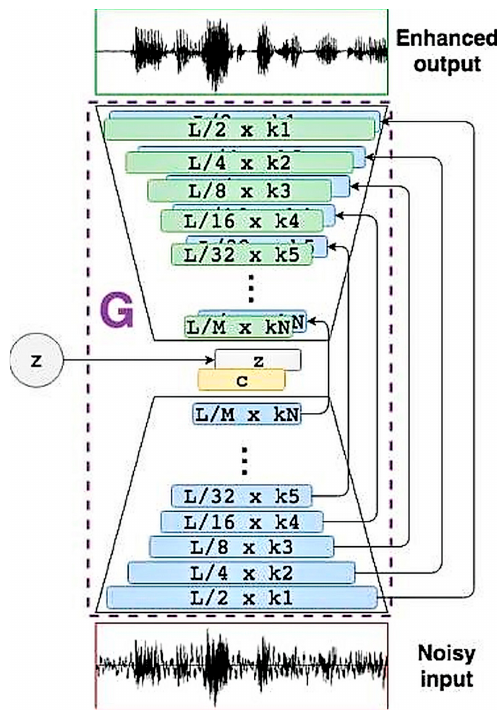
Figure 20. Encoder-decoder architecture for speech enhancement (G network). The arrows between encoder and decoder blocks denote skip connections.